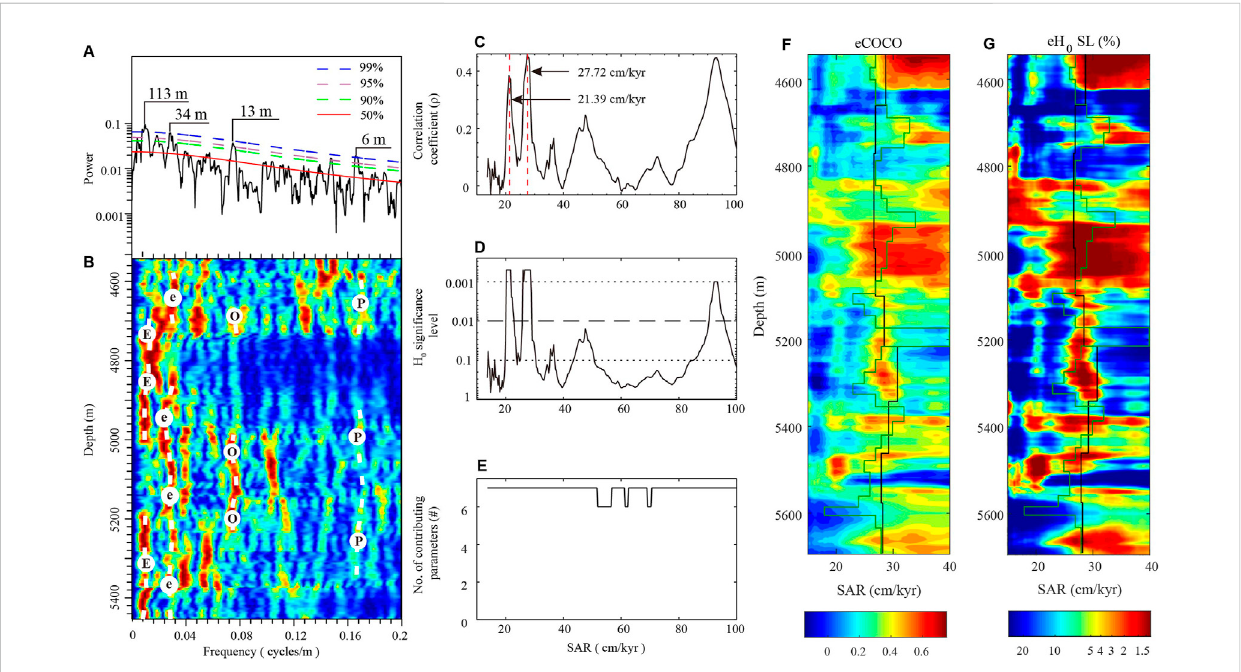
FIGURE 5 Powerspectra,COCOandeCOCOanalysisforthe χ seriesofthelowerK 1 shFormation (A) 2 π MTMpowerspectrumofthe χ series.Thesolidredline, dashed green, purple, and blue lines represent the 50%, 90%, 95%, and 99% con fi dence levels (B) Evolutive harmonic analysis (EHA) results with a sliding window of 120 m and a step rate of 1 m. The red to blue colors represent high to low power normalized to 1. The dashed white lines marked with E, e, O and P show the orbital long eccentricity, short eccentricity, obliquity, and precession cycles, respectively (C – E) COCO analysis of the untuned χ series. The results are shown as the correlation coef fi cient spectrum ( ρ ) (C) , H 0 (null) hypothesis test (D) , and the number of contributing astronomical frequencies ( # ) (E) . Tested SARs range from 1 to 100 cm/kyr (F, G) eCOCO analysis of the untuned χ series. The evolutionary ρ and evolutionary H 0 (null) hypothesis test are overlapped with SAR curves (black lines) based on 405-kyr tuning and 105-kyr tuning. Tested SARs range from 1 to 40 cm/kyr. The sliding window size is 150 m with a step of 1.0513 m. For both the COCO and eCOCO, the running step of the SAR is 0.28778 cm/kyr and the number of Monte Carlo simulations is